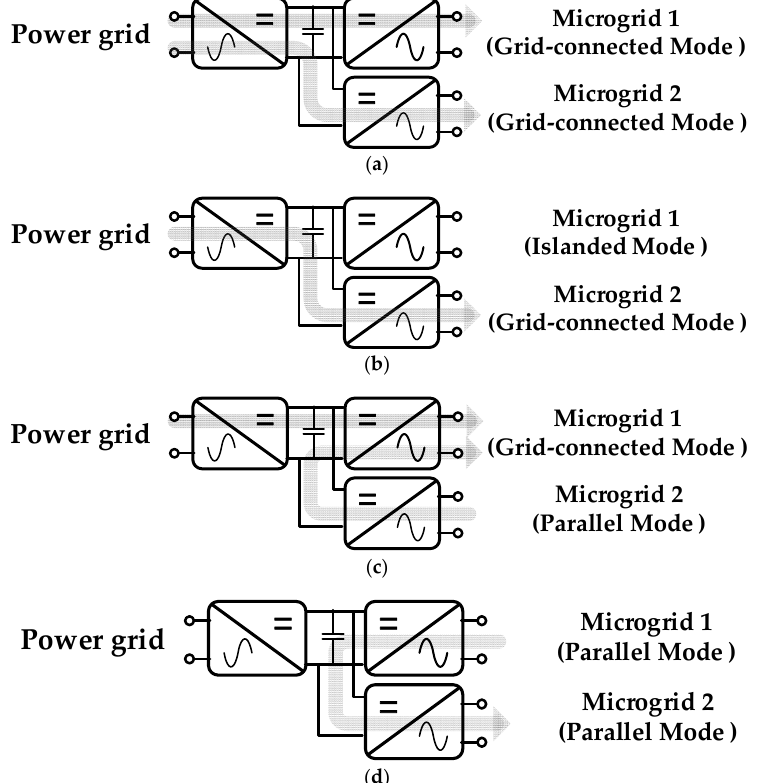
Figure 3. Operational modes enabled by the energy router: ( a ) case 1: grid-connected mode; ( b ) case 2: grid connected mode vs. islanded mode; ( c ) case 3: grid connected mode vs. parallel mode; and ( d ) case 4: parallel mode.